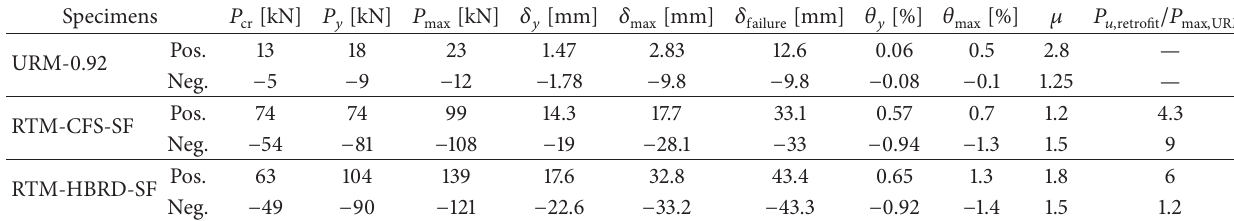
Table 5: Summary of test